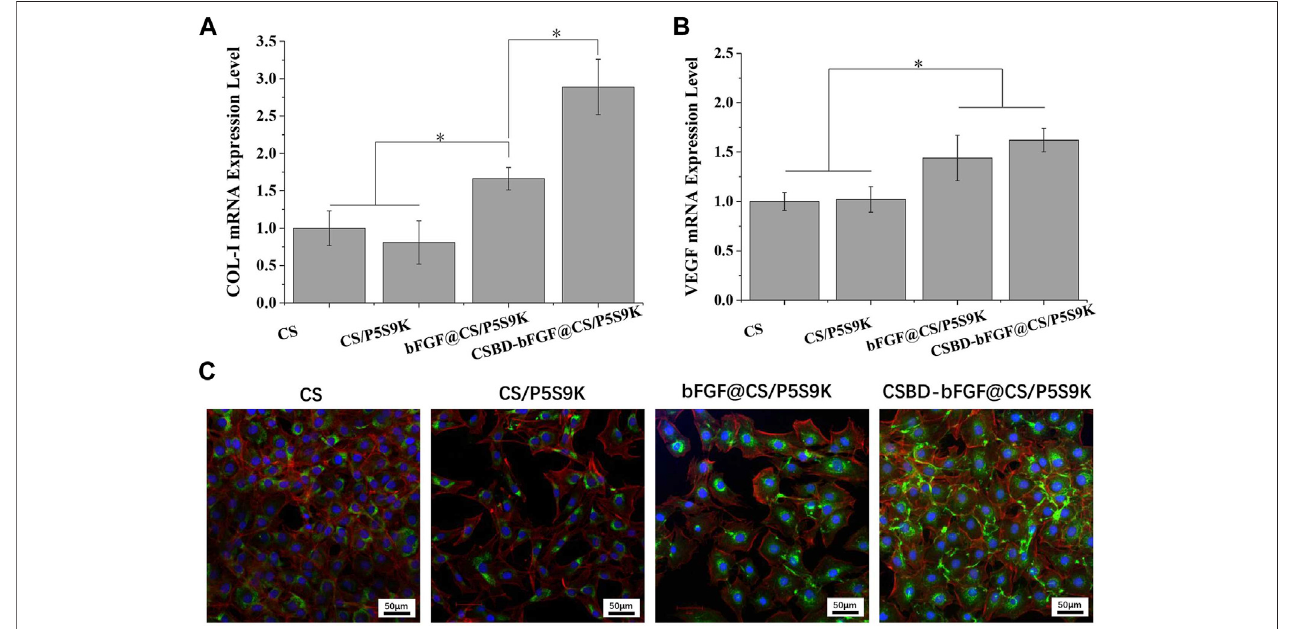
FIGURE7| Quantitative real-timePCRanalysisoftissue repair-related geneexpression of (A) COL-Iand (B) VEGFafter NIH3T3 cellswereculturedfor4 days. (C) Immuno fl uorescent images of COL-I protein for different samples on 4 days. The green fl uorescent indicates the COL-I, the blue fl uorescent indicates the cell nucleus stained with DAPI and the red fl uorescent indicates the cytoskeleton stained with Alexa Fluor 555 labelled phalloidine. Scale bar lengths are 50 μ m, n = 3, p < 0.05.